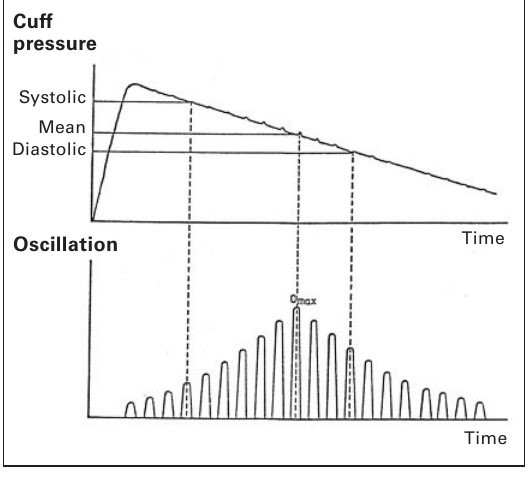
Figure 1 Oscillometric blood pressure measure- ment. With this method, the magni- tude of the pressure vacillation under the cuff is measured as it deflates from suprasystolic pres-